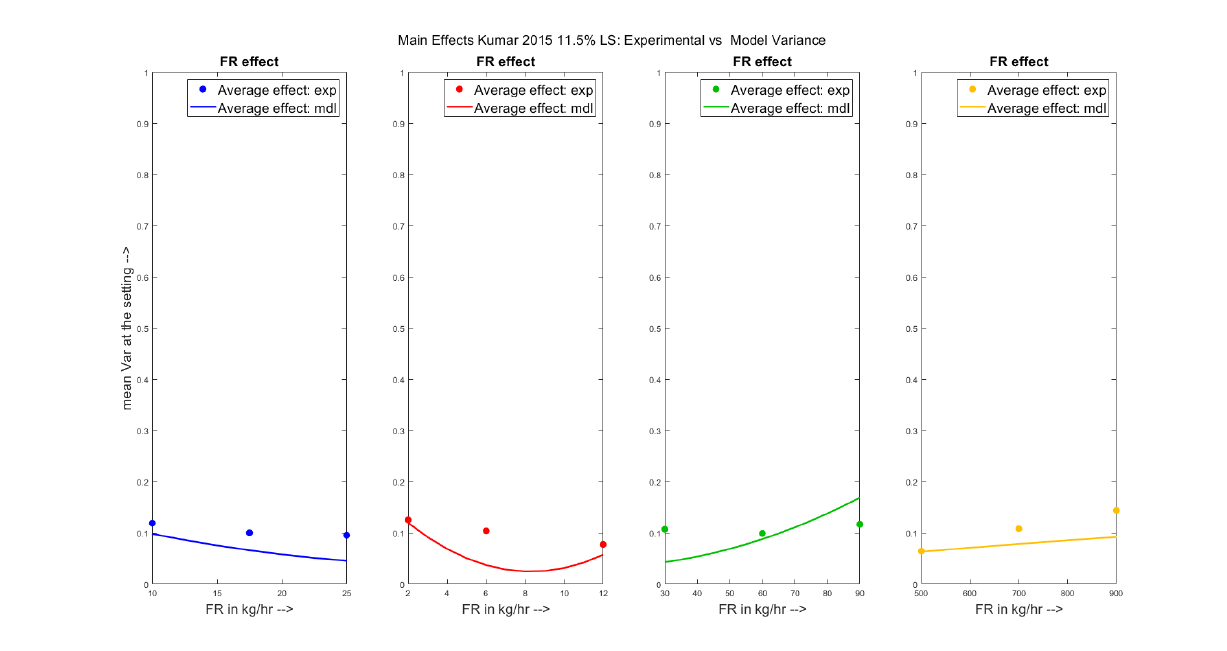
Figure 5. Experimental results vs. Model predictions: Main effects of varied parameters on MRT for the Kumar et al. 2016 [26] dataset.